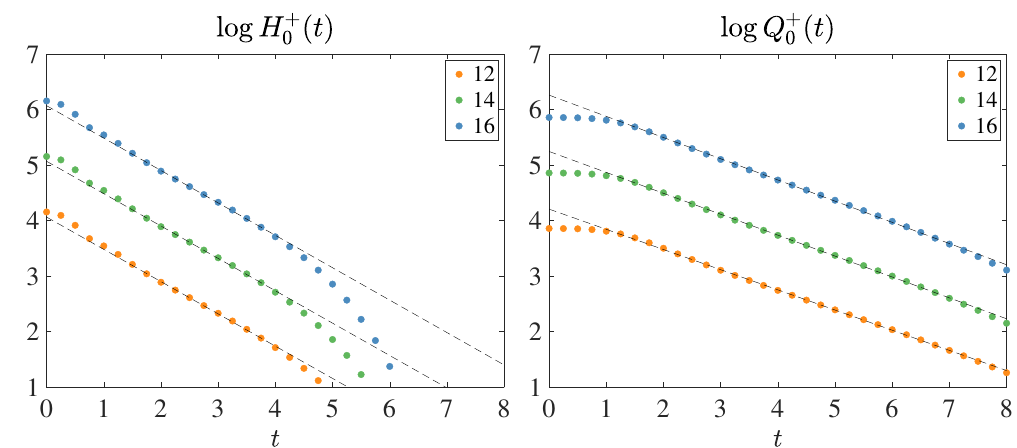
( t ) and log Q + ( t ) for fixed κ = 1 . 5 and various choices of Figure 6 . The functions log H + 0 0 . In all cases T = 0 . The intermediate times σ = 12 , 14 , 16 . Recall that log(2 T m ) = κ + σ a 2 linear fit is of the form log H + ( t ) = − t + ξ and log Q + ( t ) = − t + ξ where τ 1 . 7 and H Q H ≈ 0 0 τ H τ Q τ Q ≈ 2 . 7 . The values of all fitting parameters are summarised in tables 5 and 6 of appendix C. For early times H + ( t ) decays as a gaussian whereas Q + ( t ) remains 0 0